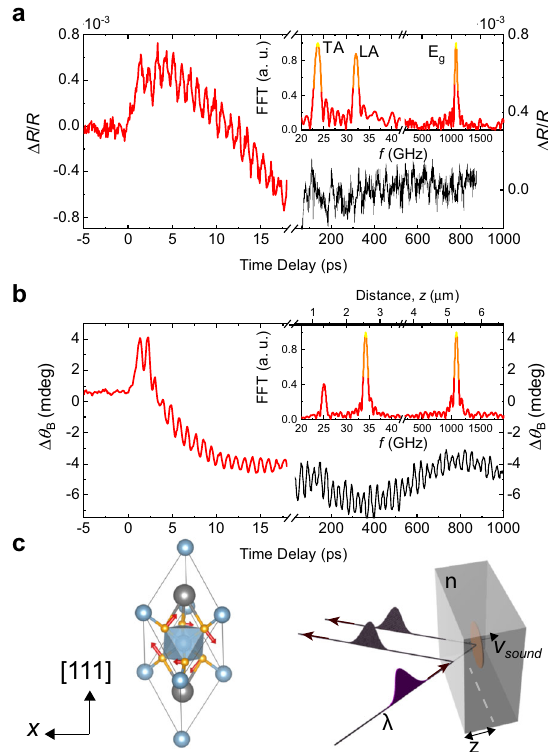
Fig. 2 Photo-induced structural dynamics. Transient changes in the intensity of the re fl ected probe pulse Δ R / R ( a ) and the polarization rotation Δ θ B of the probe pulse ( b ) after excitation of the LaAlO 3 substrate with a mid-infrared pump pulse of 86 meV ( a ) and 89 meV ( b ) and a fl uence of 10 mJ cm − 2 . The insets show the Fourier spectra of the signals. The top axis in b shows the distance z which the longitudinal sound wave has propagated at that time. c The real-space atomic motion corresponding to the excited E g mode indicated with arrows (left) and a schematic picture of a strain wave propagating with speed v sound leading to interference between probe light (wavelength λ ) re fl ected at the interface and scattered at the strain wave, depending on the distance z which the strain wave has propagated